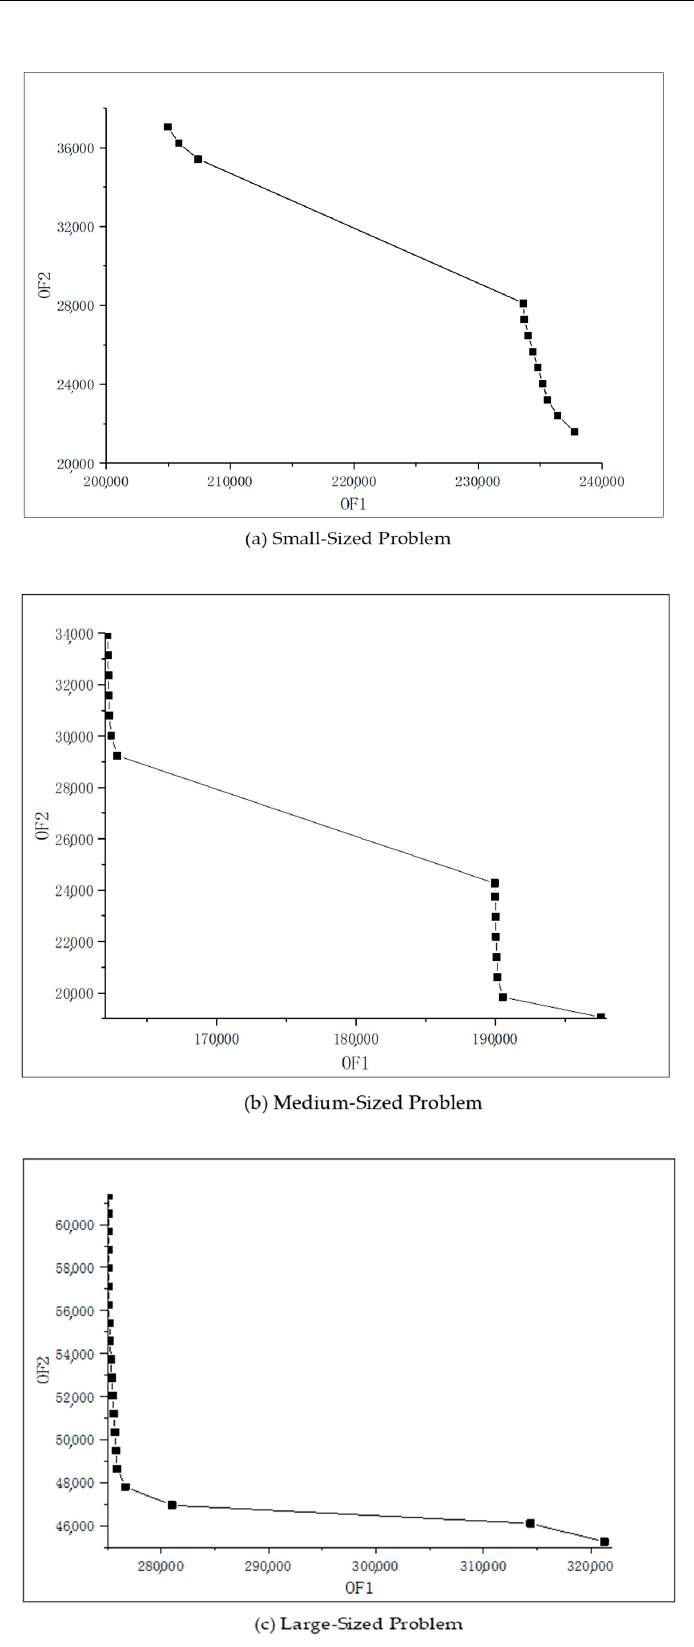
Figure 6. Pareto frontier for three sets of problems: ( a ) small-sized problem; ( b ) medium-sized problem; ( c ) large-sized problem.